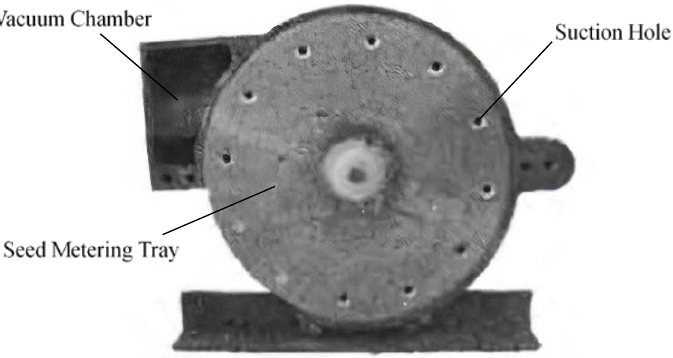
Figure 6. Pneumatic-type seed metering device. Reprinted with permission from ref. [31]. Copyright 2019 Chinese Society for Agricultural Machinery.